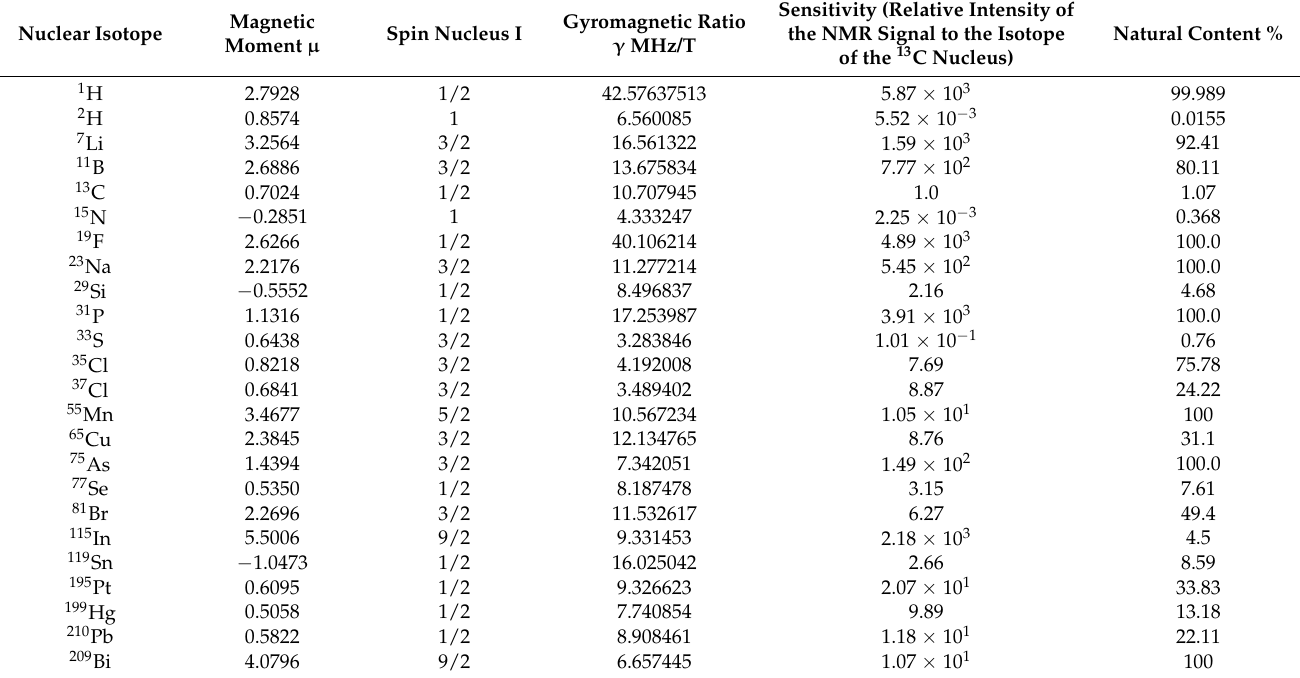
Table 1. Table 1. Characteristics of nuclei used in nuclear magnetic